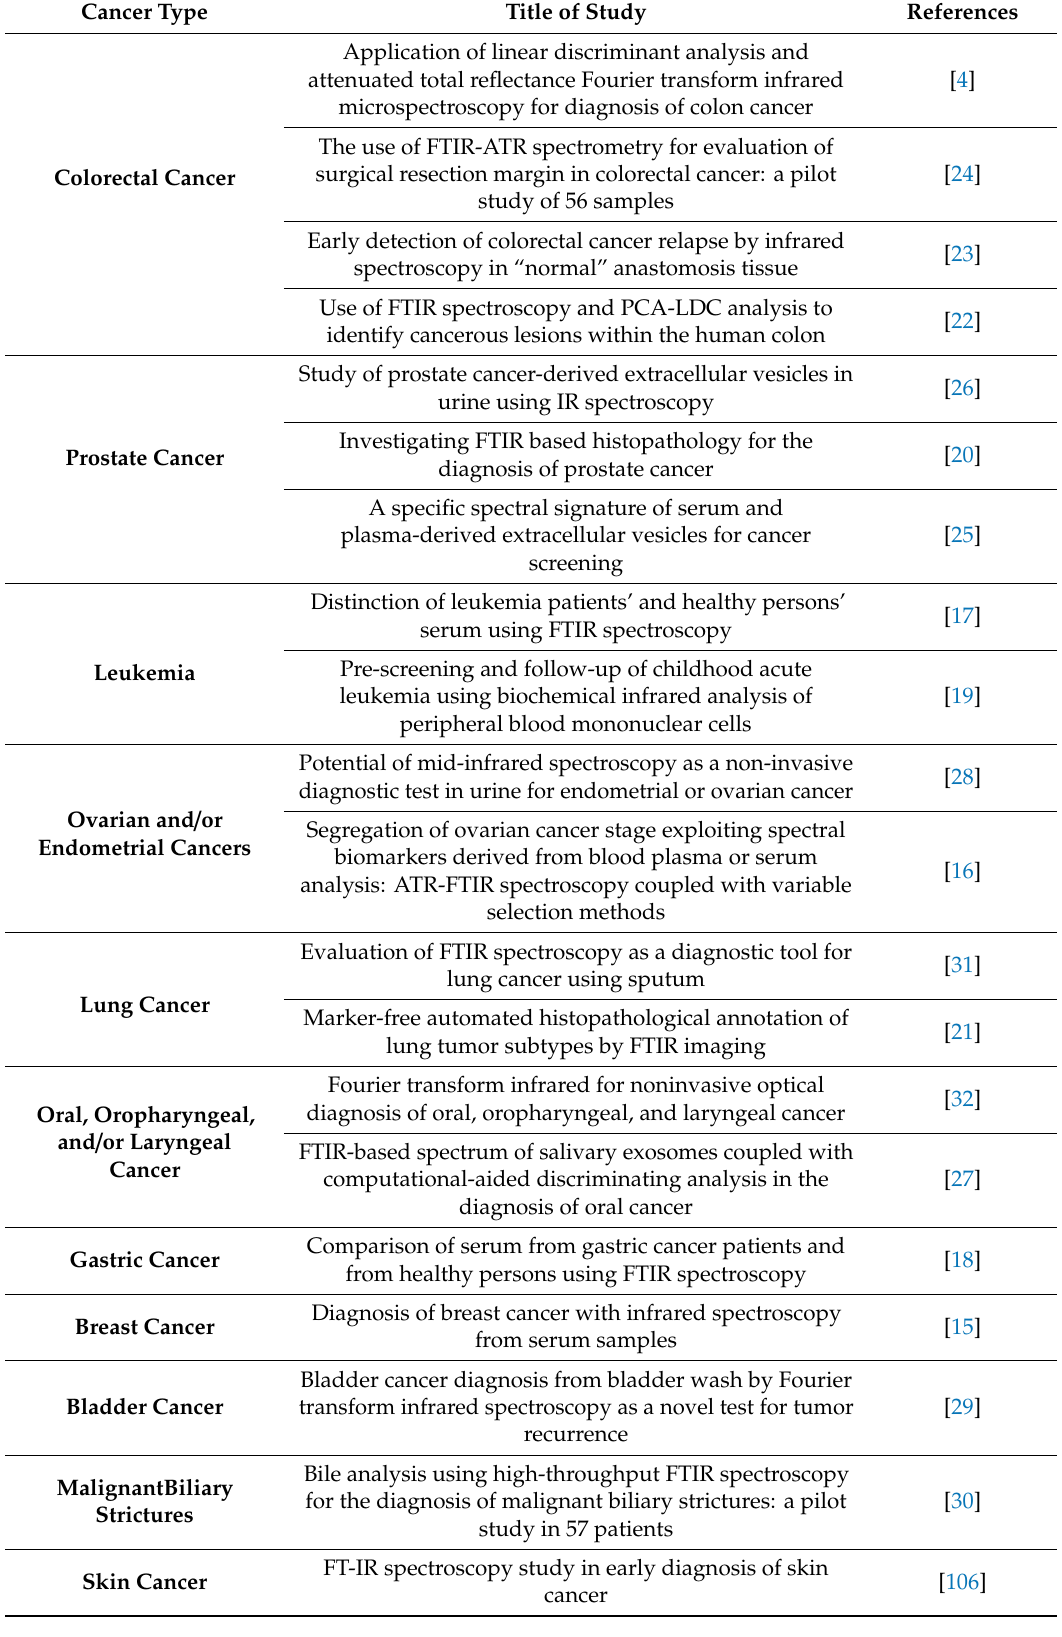
Table 2. Studies of various cancer types using FTIR spectroscopy discussed in this review article. Cancer